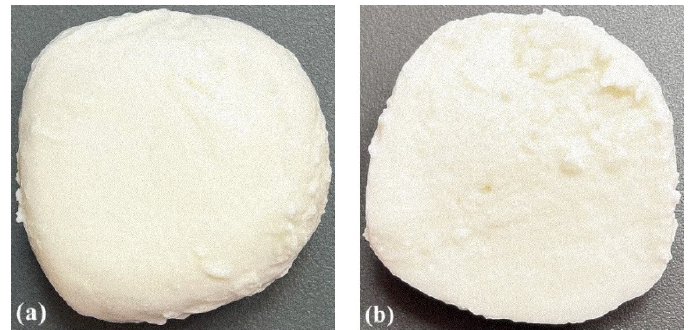
Figure 3. Outer layer ( a ) and inner layer ( b ) of pasta filata cheese from cow’s and sheep’s milk in proportion 70:30.